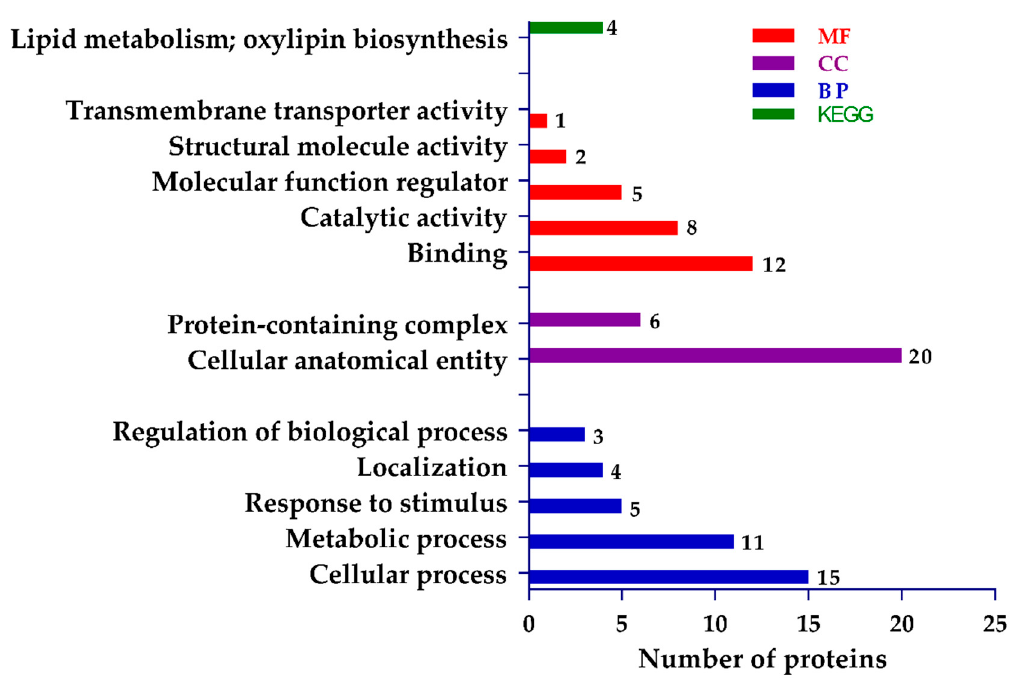
Figure 5. Gene ontology (GO) classification and pathway assignment of differentially expressed proteins (DEPs).